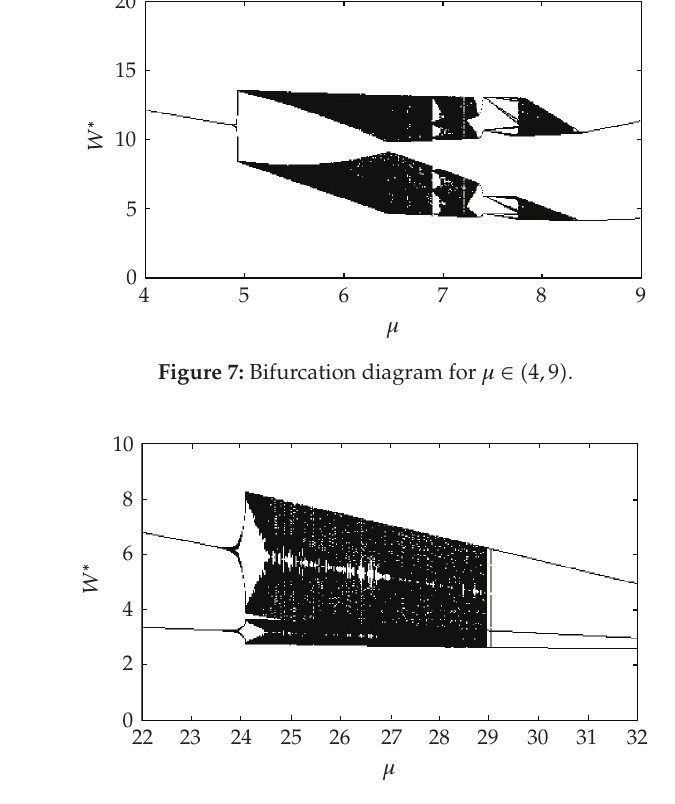
Figure 8: Bifurcation diagram for μ ∈ (cid:3) 22 , 32 (cid:4)